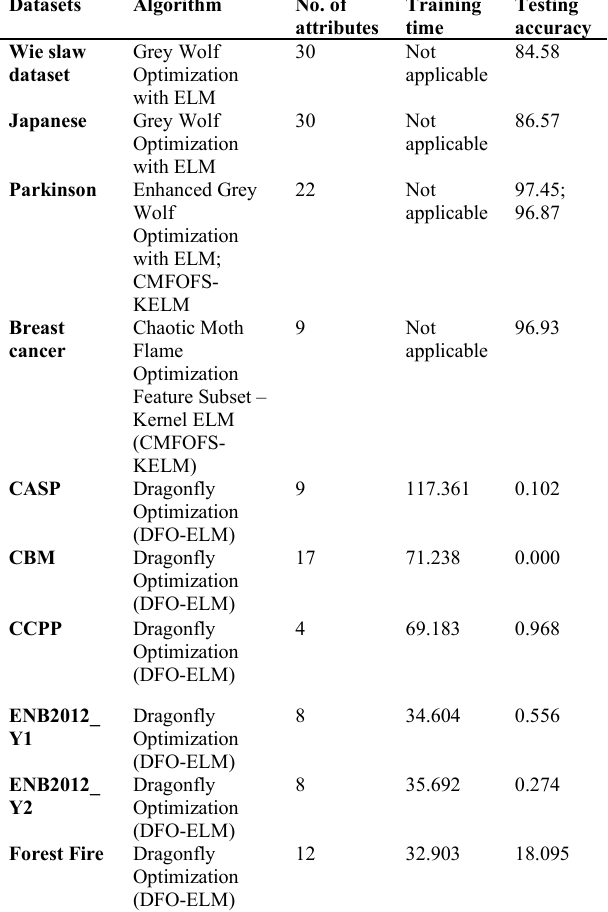
Table 5. Algorithm accuracy of the suggested techniques in the aspect of datasets